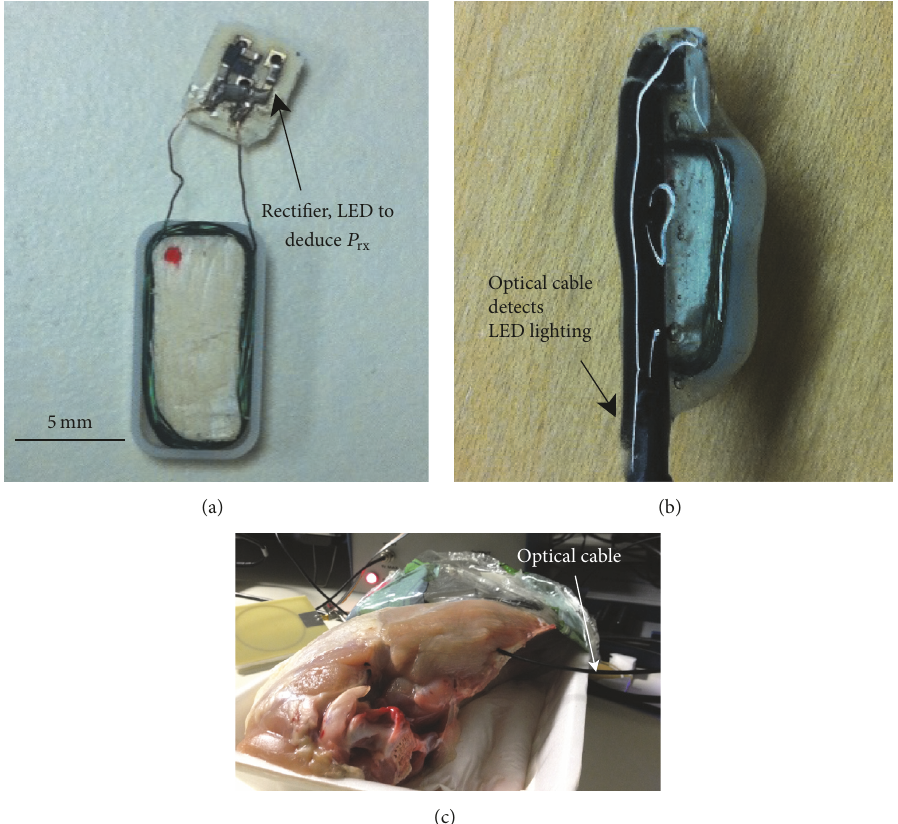
Figure 5: (a) Multiturn loop fits inside the same cover used in the ATI product. (b) Optical cable attached to detect LED lighting. (c) Turkey breast used for the